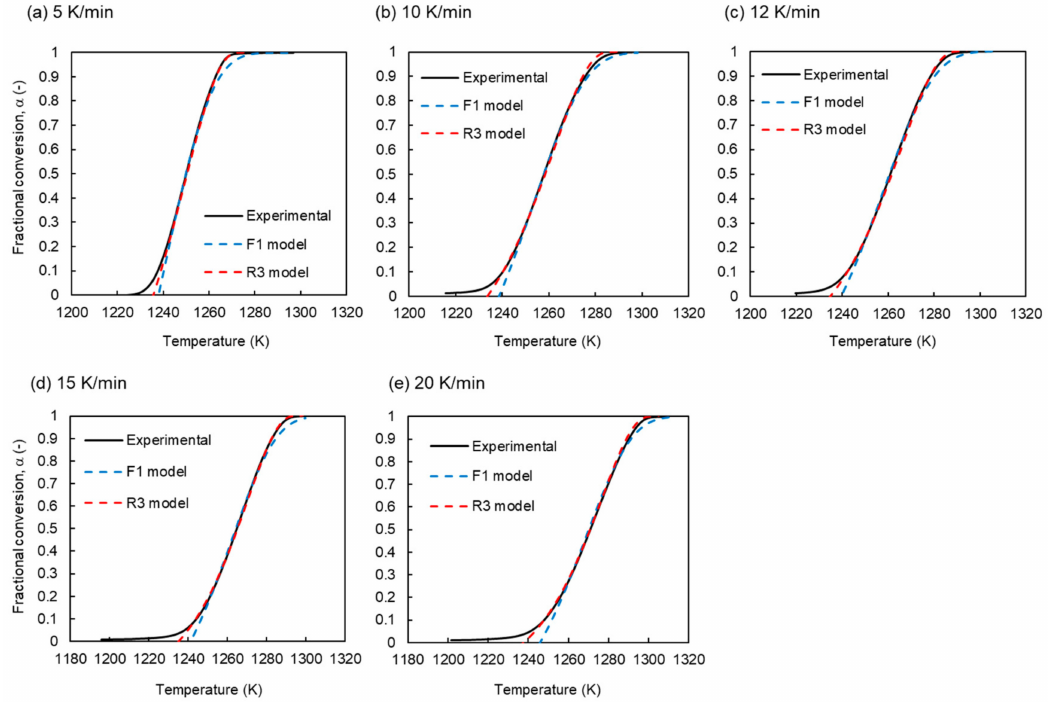
Figure 9. Temperature variation in the fractional conversion, α , of the as-prepared sample during the HC mode for experimental (black curve) and predicted reaction models (red and blue curves for R3 and F1 models, respectively); the data of heating rate ( a ) 5 K/min, ( b ) 10 K/min, ( c ) 12 K/min, ( d ) 15 K/min, ( e ) 20 K/min. The curves are compared in these figures for validation of the predicted reaction